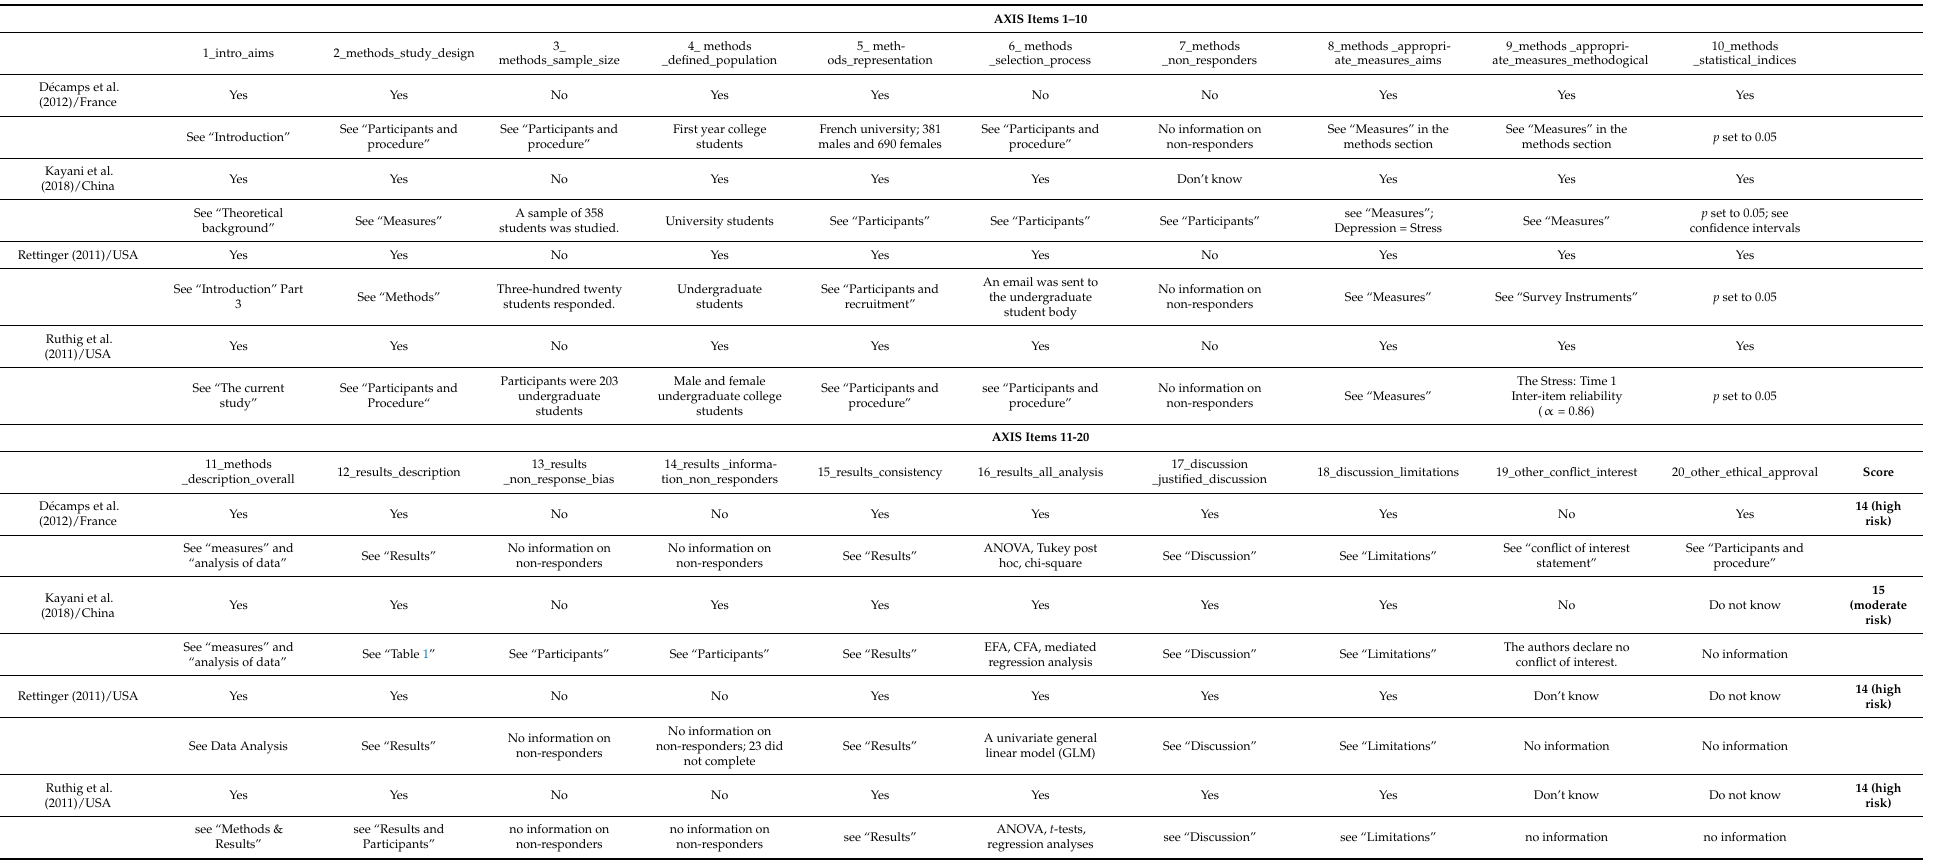
Table 2. Risk of bias assessment using the Appraisal Tool for Cross-Sectional Studies (AXIS) tool for included studies.